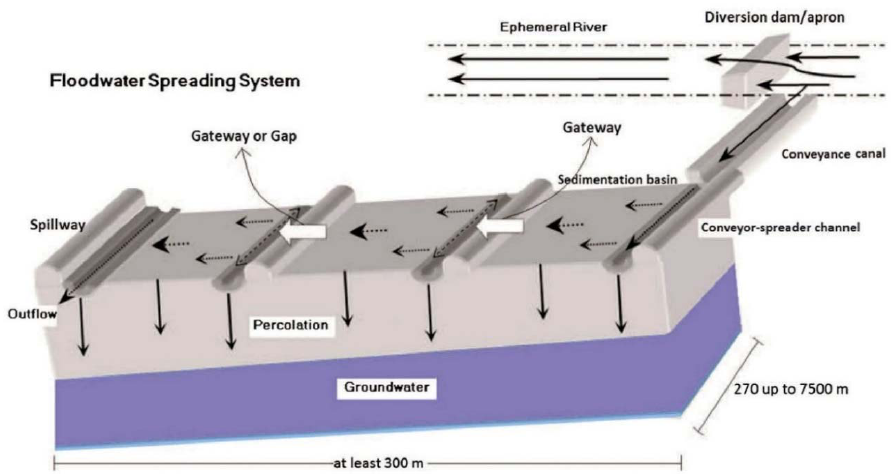
Figure 3. The schematic presentation of the WFS system (Source: Adapted from Hashemi et al. 2015)